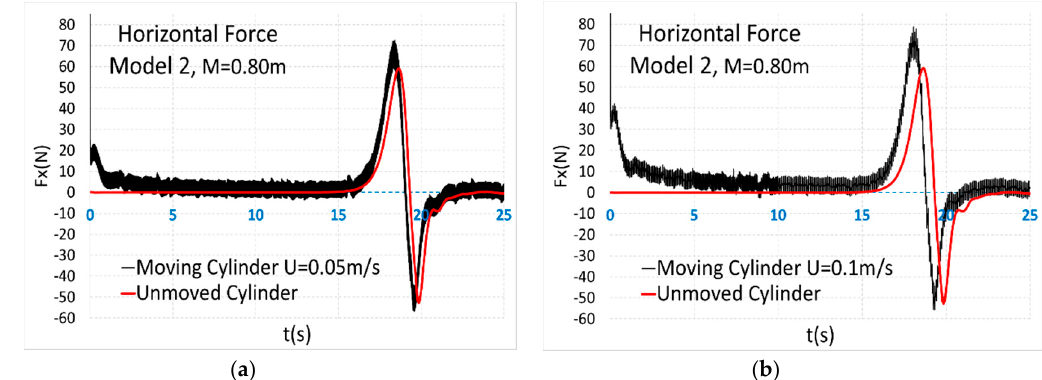
Figure 9. The time variation of the horizontal forces for model 2. ( a ) A comparison between the unmoved cylinder (red line) and the moving cylinder at U c = 0.05 m/s. ( b ) A comparison between the unmoved cylinder (red line) and the moving cylinder at U c = 0.1 m/s.